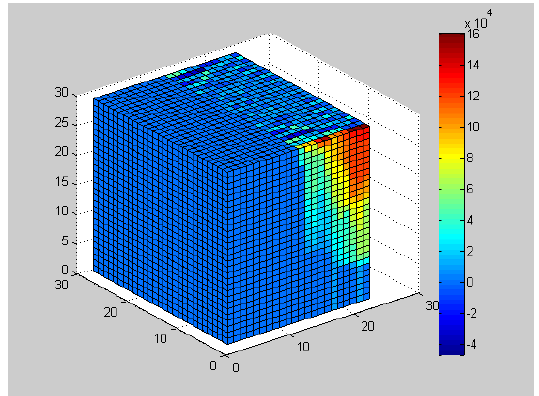
Figure 2. The FFT domain signal of temperature data.